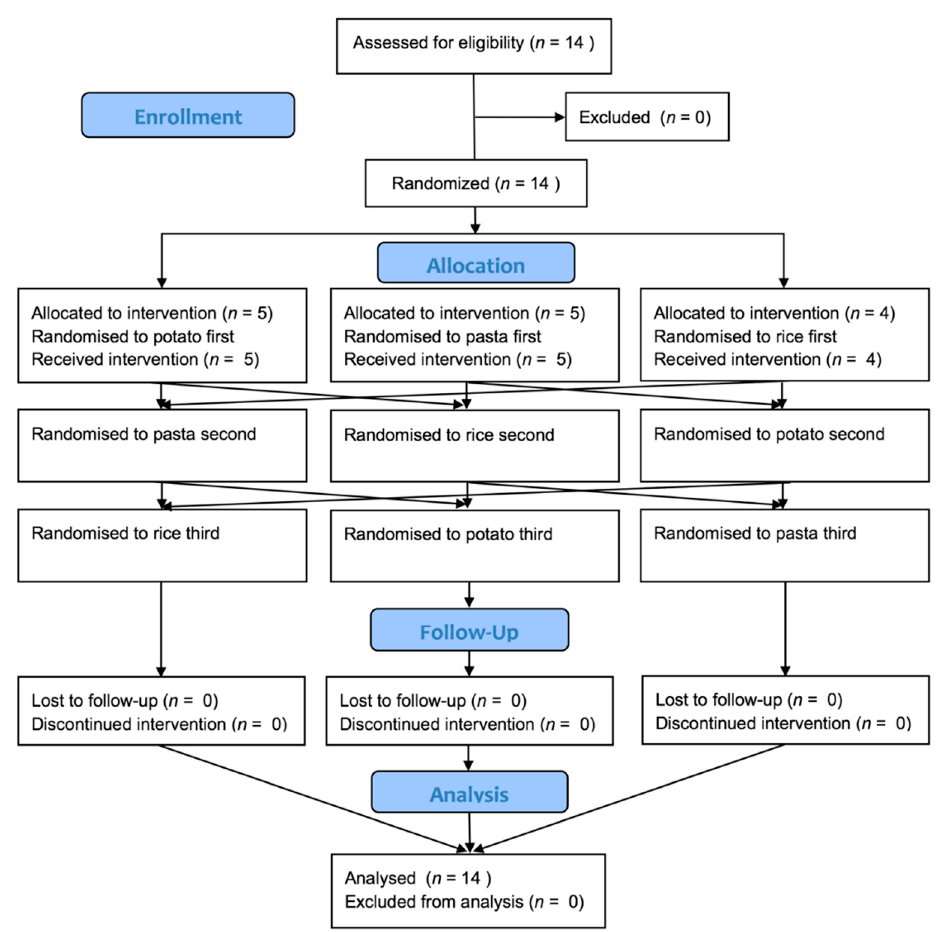
Figure 1. CONSORT diagram showing the flow of participants through the study. Table 3. Mean visual analogue scale (VAS) outcomes of 14 people in response to four satiety questions. Mean (SD) Mean Difference (95% Confidence Interval) Comparing between Meals Given in the Column Headings above Satiety Measure 1 Pasta Potato Rice Pasta vs. Potato Pasta vs. Rice Rice vs. Potato Hunger AUC